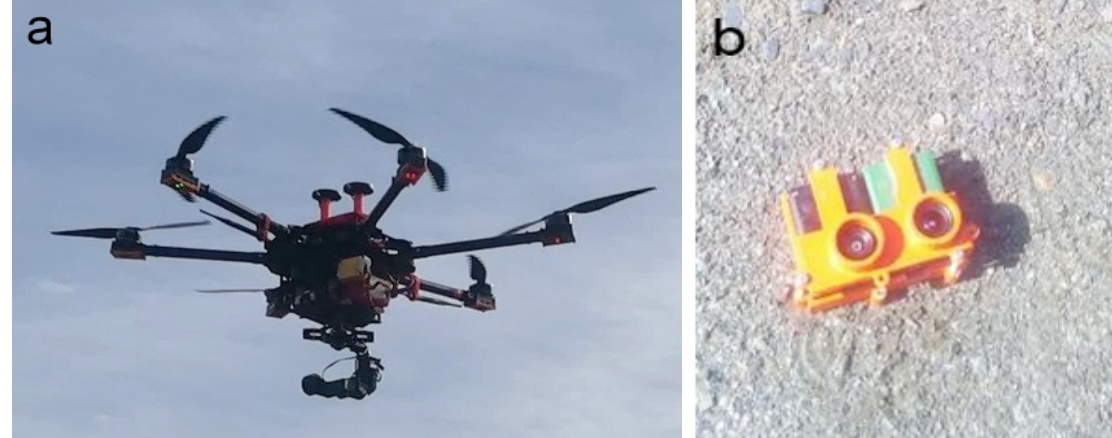
Figure 4. UAV system with two cameras in flight ( a ); RGB and multispectral cameras installed in the mount ( b ).